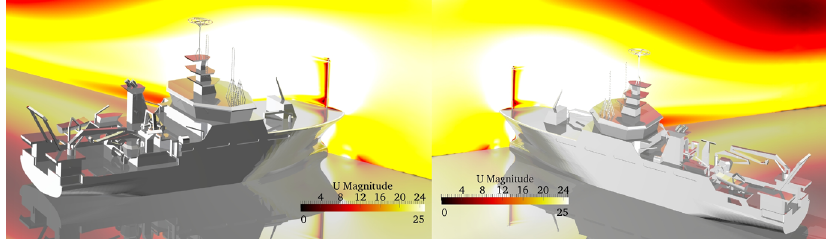
Fig. 6. (a) Flow speed over the ship for − 60 and + 60 ◦ to the bow for a steady-state input stream of 25ms − 1 . Table 1. Mean differences between numerical and experimental anemometer ratio bin-averaged data in Fig.